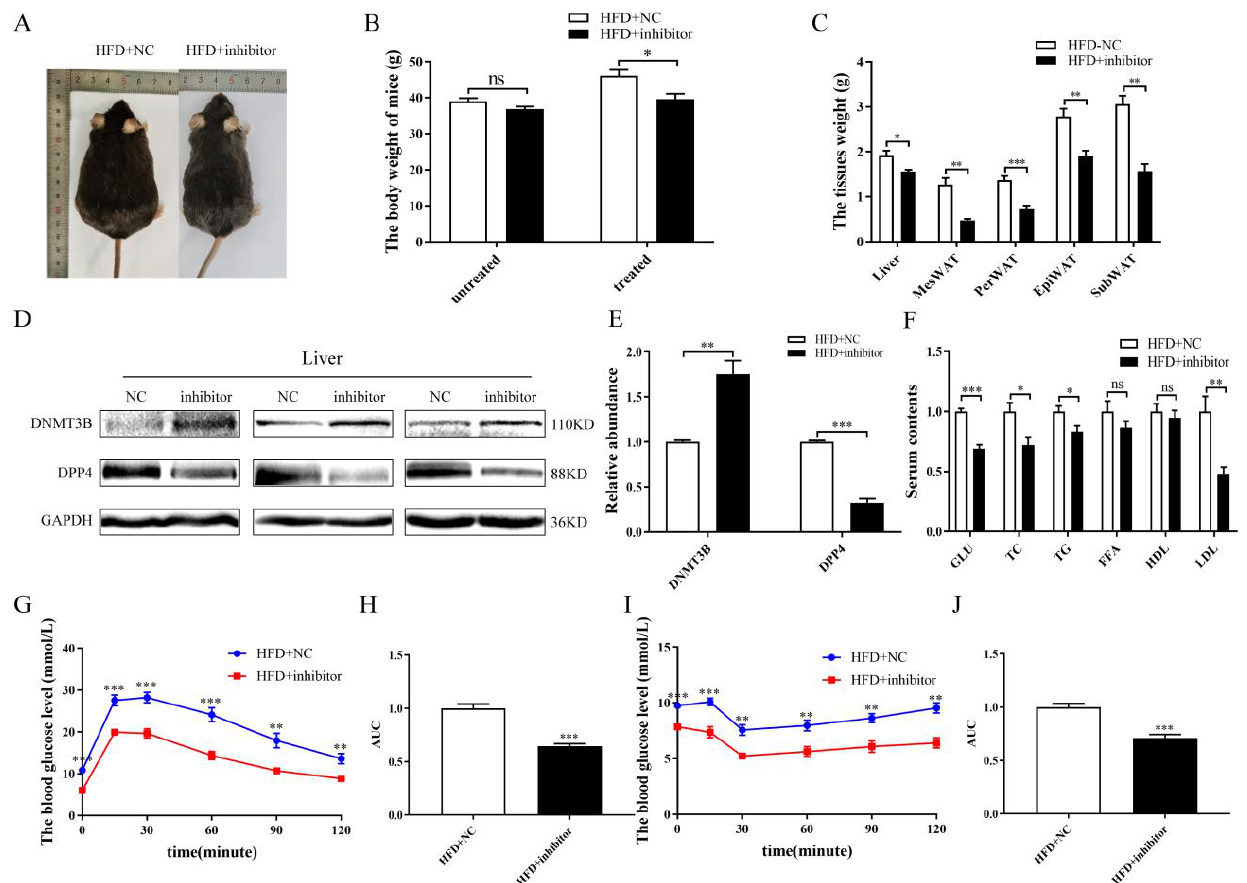
Figure 6. Effect of the miR-548ag inhibitor on the expressions of DNMT3B and DPP4 in vivo. ( A ) The gross morphology of the HFD + NC and HFD + inhibitor mice. ( B ) Comparison of the body weights prior to and after the intraperitoneal injection of the inhibitor ( n = 8). ( C ) The weights of the liver and adipose tissues ( n = 8). ( D , E ) The protein expressions of the DNMT3B and DPP4 in the liver ( F ) The levels of blood glucose, TC, TG, FFA, HDL, and LDL ( n = 8). ( G ) IPGTT assay results ( n = 8). ( H ) The quantification of glucose tolerance. ( I ) ITT assay results ( n = 8). ( J ) The quantification of insulin sensitivity. (The p -values obtained in the t -test and non-parametric rank sum test are indicated. The data are presented as mean ± SEM. * p < 0.05, ** p < 0.01, and *** p < 0.001 indicate a significant difference).